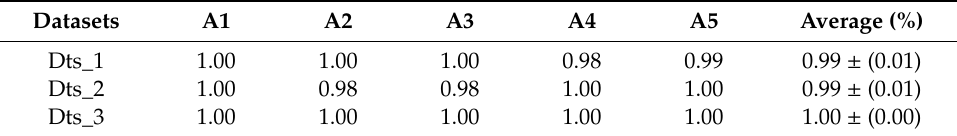
Table 13. Cross validation accuracies calculations using the final classifier.